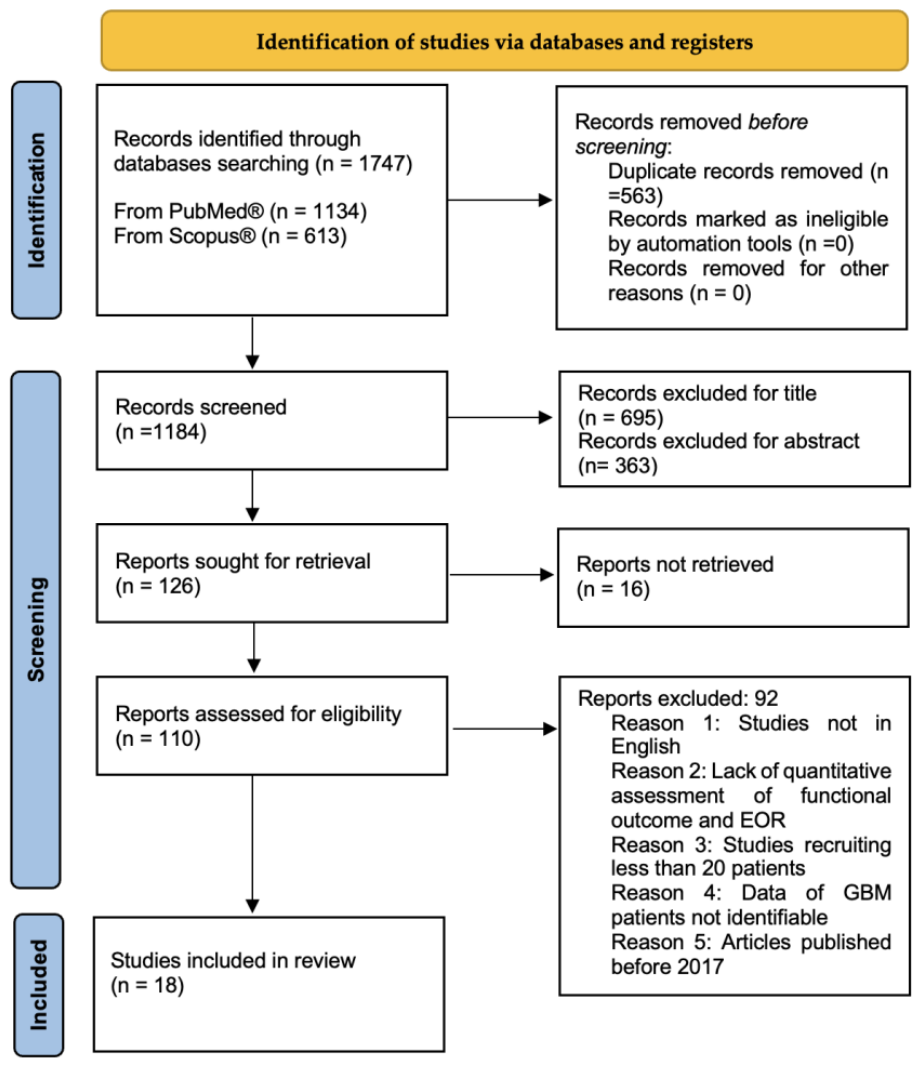
Figure 1. PRISMA flow chart of selection process.